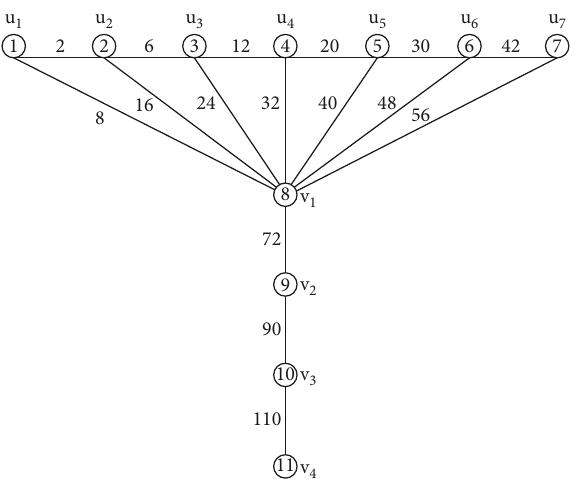
Figure 3: Representation of GP(6, 2) with strongly multiplicative